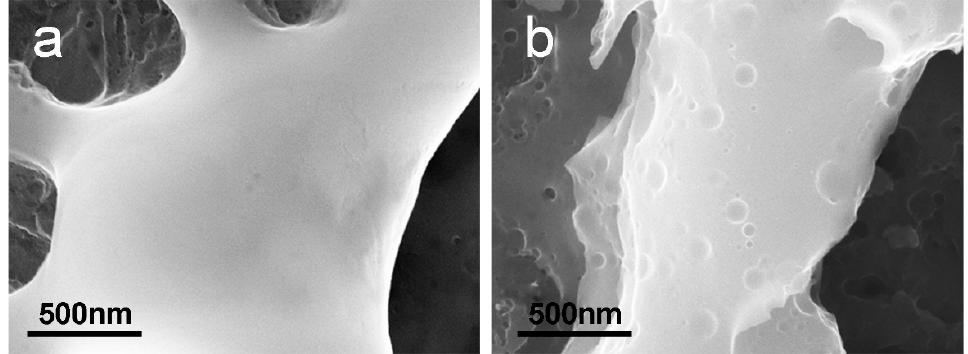
Figure 4. High resolution SEM images of post-anodizing etching effects: ( a ) a pore border of a typical anodized sample; ( b ) nano-sized pits on a pore border after etching.